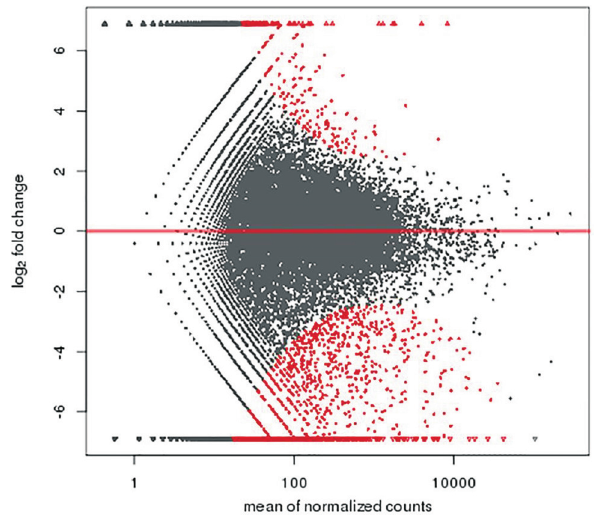
Figure 3 - A total of 1,367 genes were differentially expressed between the anti-B7 group and control group, among which 618 genes were up-regulated and 749 down-regulated. Abscissa: mean of normalized counts; Ordinate: log 2 fold change.